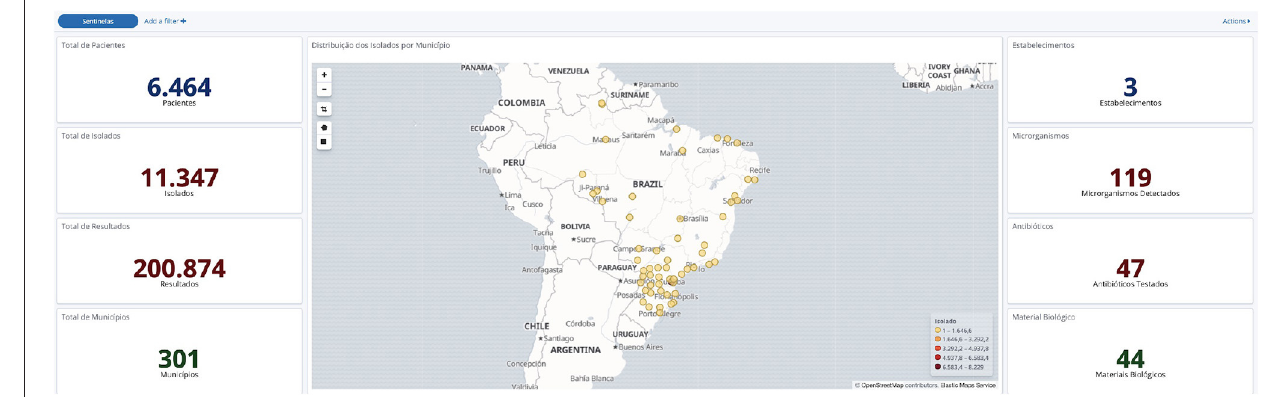
FIGURE 1 | General data obtained from the BR-GLASS Platform.